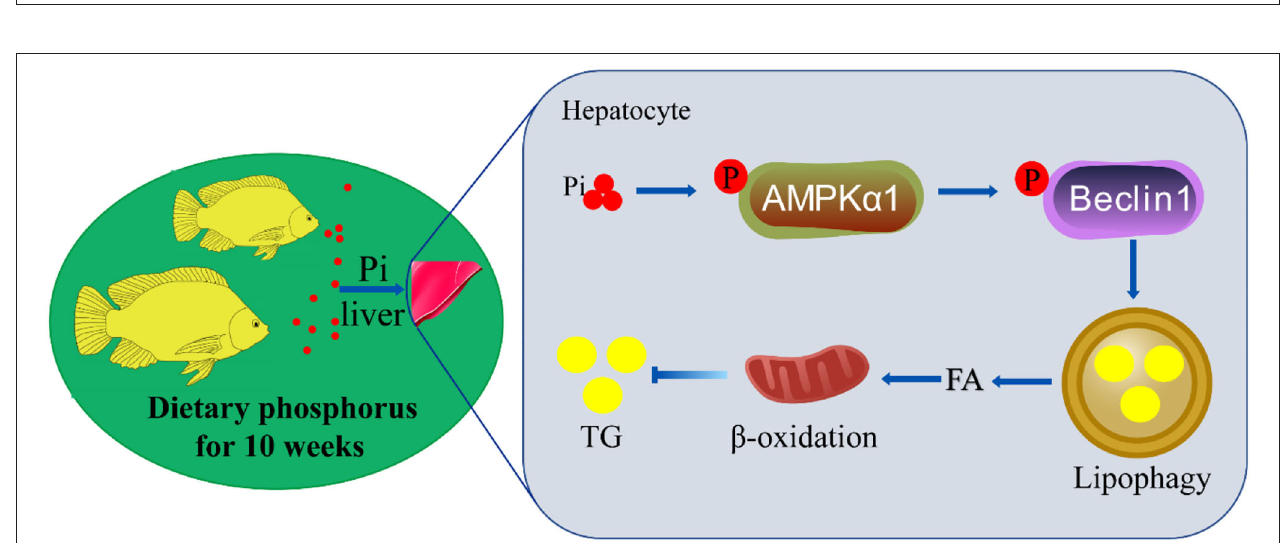
FIGURE 10 | The mechanisms of dietary phosphorus inducing lipid degradation and lipophagy through AMPK/Beclin1 pathways. Dietary phosphorus activated AMPK α 1 phosphorylation, triggered lipophagy by phosphorylating Beclin1, and induced lipid degradation of the liver tissues of tilapia.